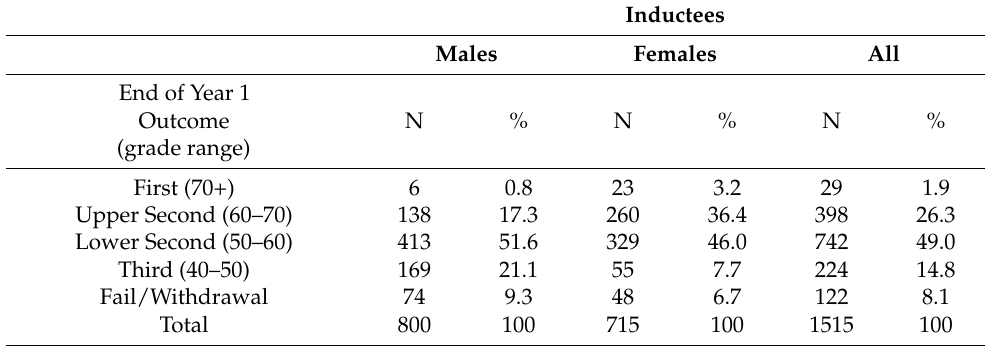
Table 5. End of Year 1 grade classifications (Cohorts 1–4) for all inductees and by